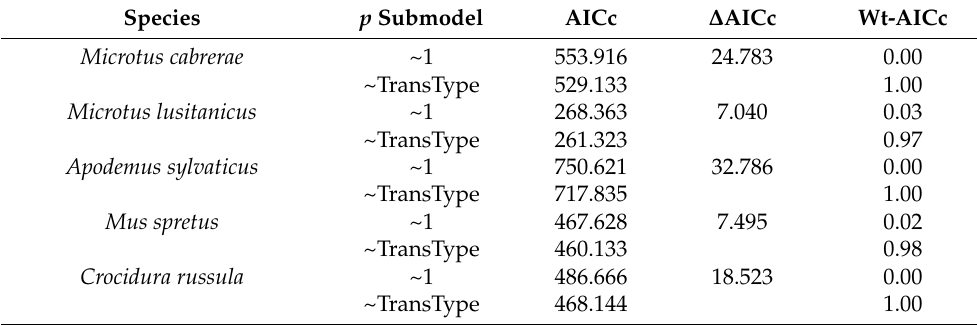
Table 1. Selection of the best submodel of detectability, assuming constant occupancy for each small mammal species ( Psi ~ 1), based on comparisons between AICc values of models considering the effects of transect type (within focal olive groves versus at neighboring semi-natural marginal habitats) and the model with no effects on detectability. In each case, the submodel including the transect type ( p ~TransType) received greater support than the model with constant detectability ( p ~ 1), and therefore, this submodel structure was carried out in subsequent analyses focusing occupancy.